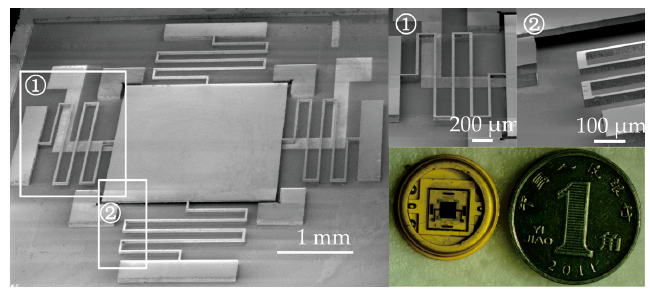
Figure 5. SEM and optical photographs of the fabricated and packaged micro-switches.